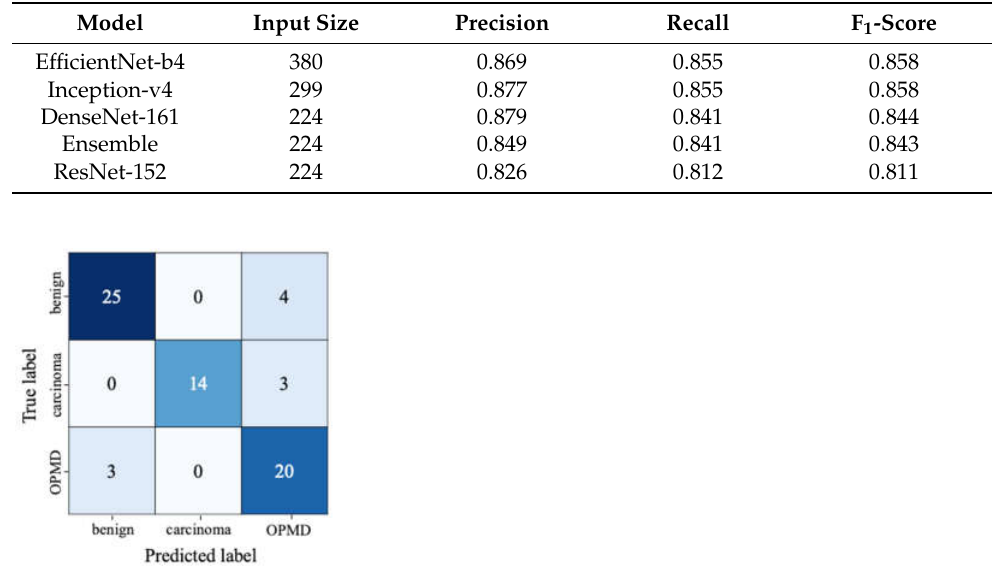
of FP and FN predictions, respectively, for each class. and FN predictions, respectively, for each